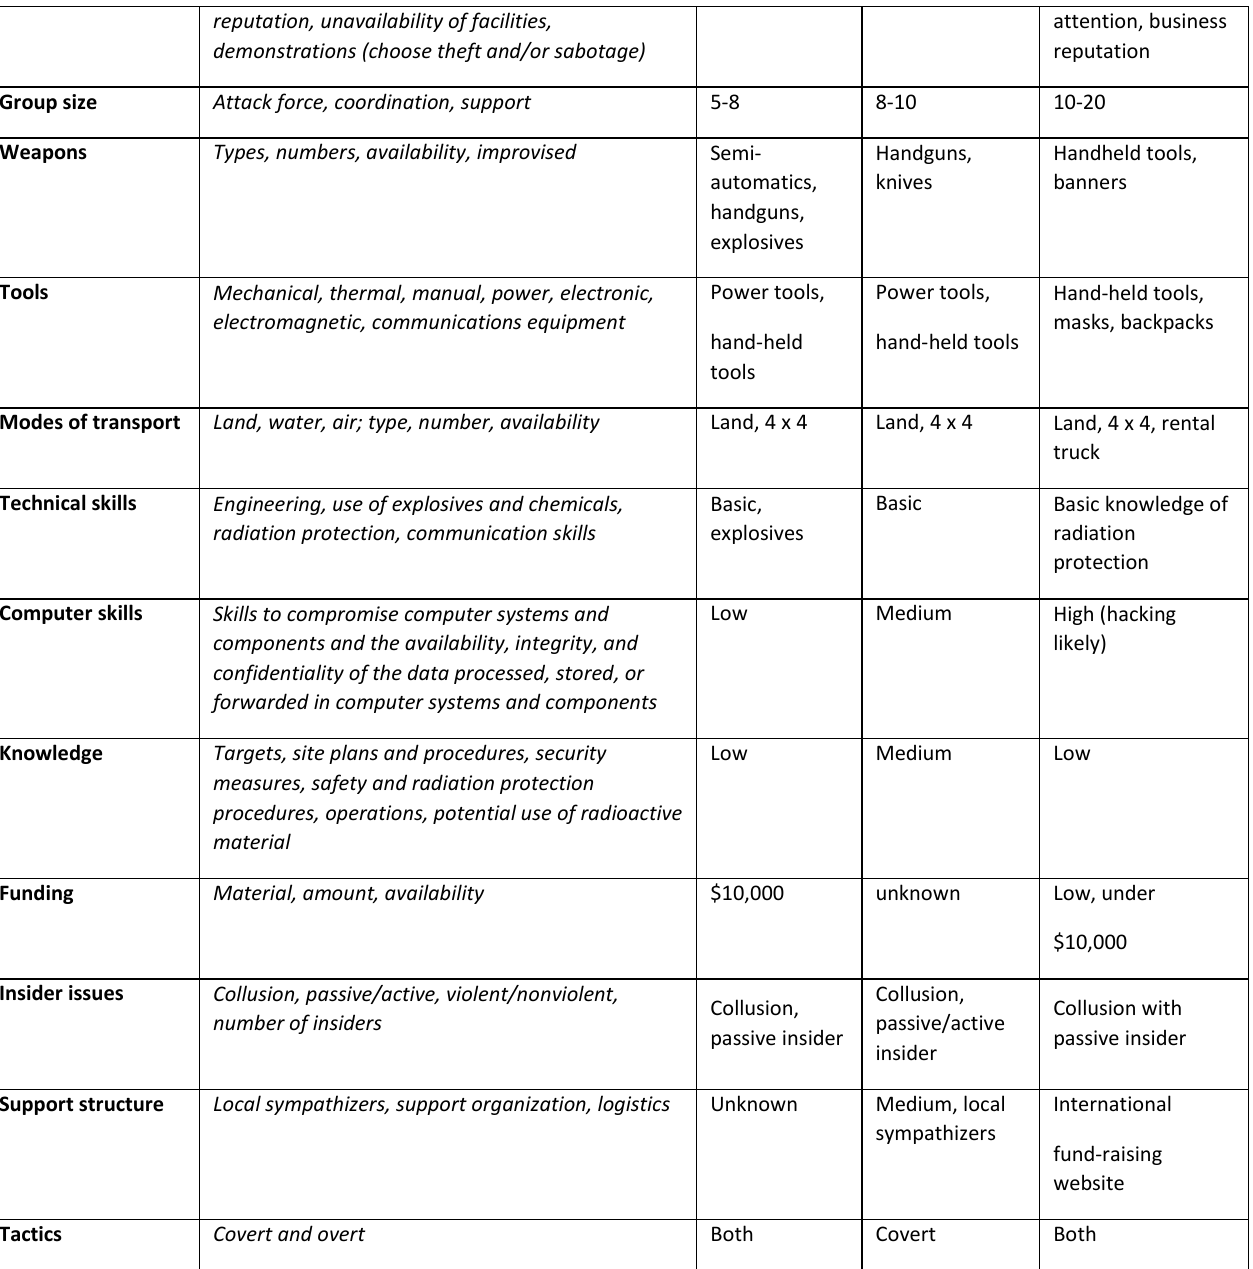
Figure 2: Generic Table of Attributes and Characteristics for Hypothetical Threats based on IAEA NSS 14 and